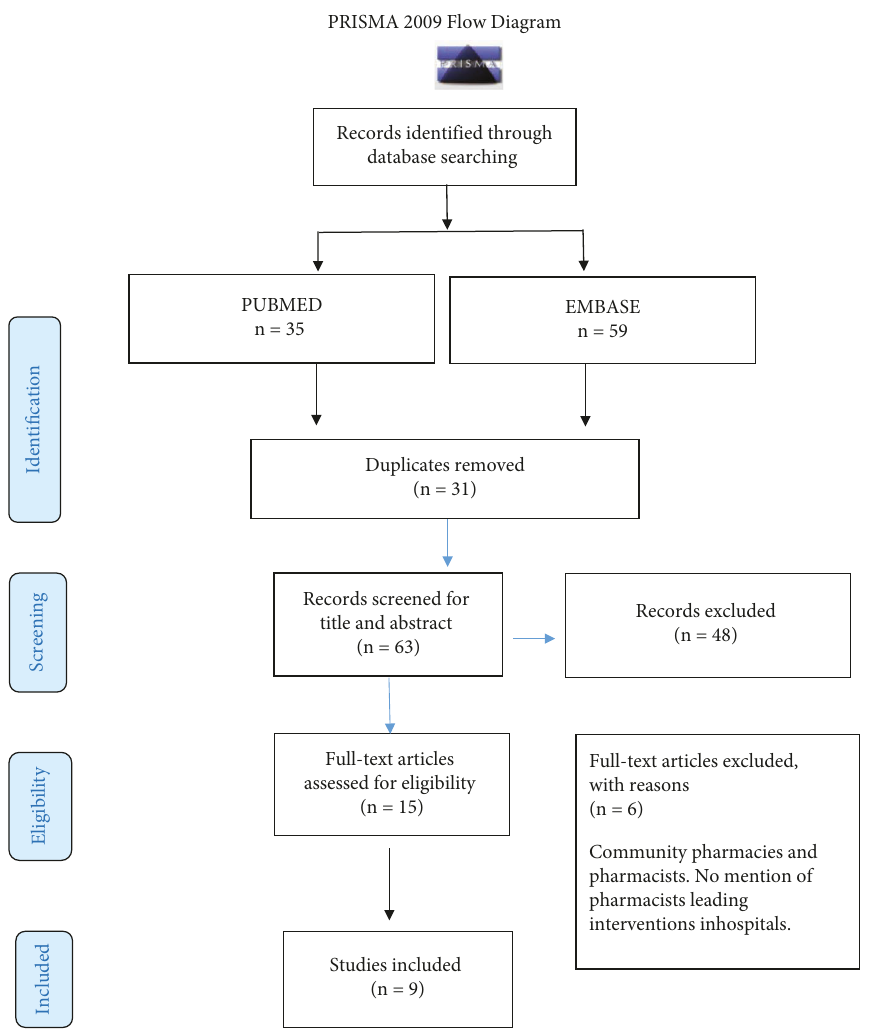
Figure 1: PRISMA diagram literature search